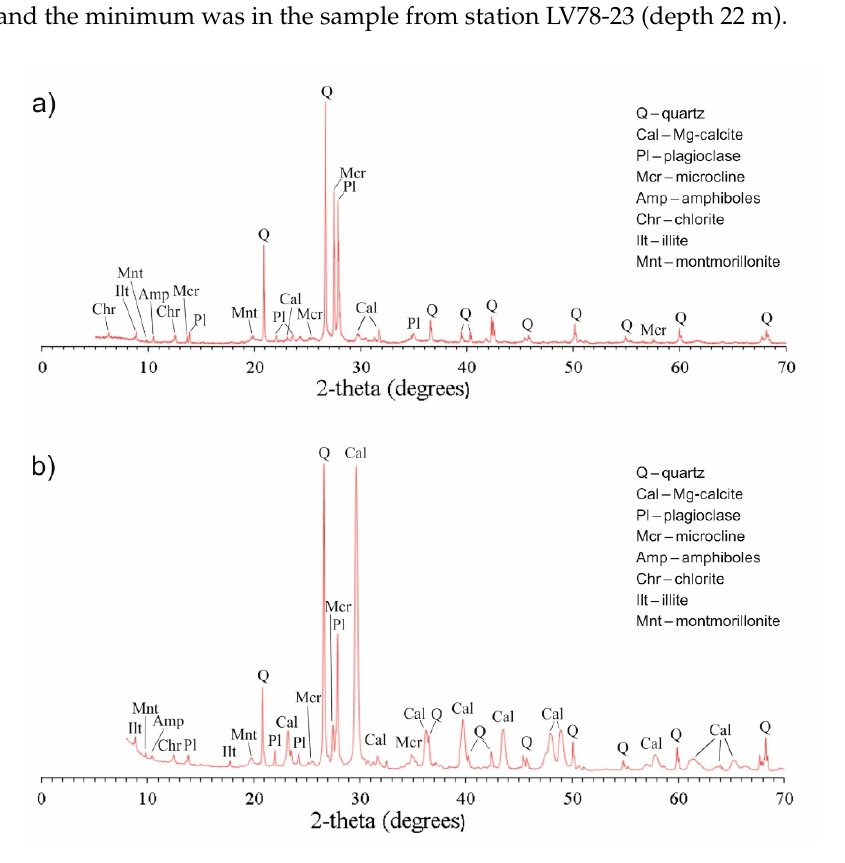
Figure 2. X-ray diffraction (XRD) patterns of host sediments ( a ) and authigenic carbonate nodules ( b ).